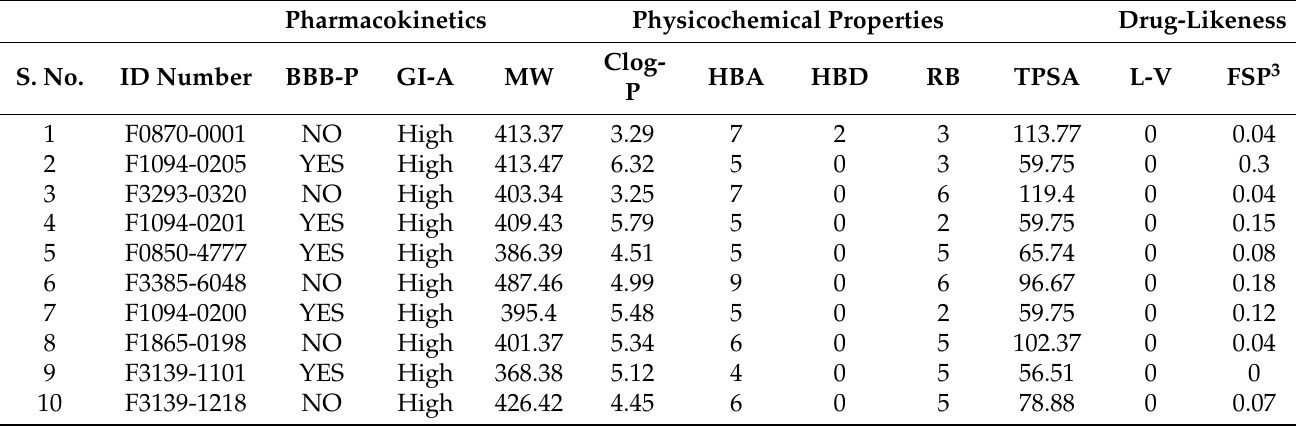
affinity towards all the target proteins and found acceptable range of physicochemical prop- erties, drug-likeness, and pharmacokinetics (Figure S1). This confirmed its amelioration of Alzheimer’s disease and was selected for molecular docking and molecular dynamics simulation analysis. Table 2. Physicochemical properties, drug-likeness, and pharmacokinetics of best hit natural product-like compounds. Pharmacokinetics